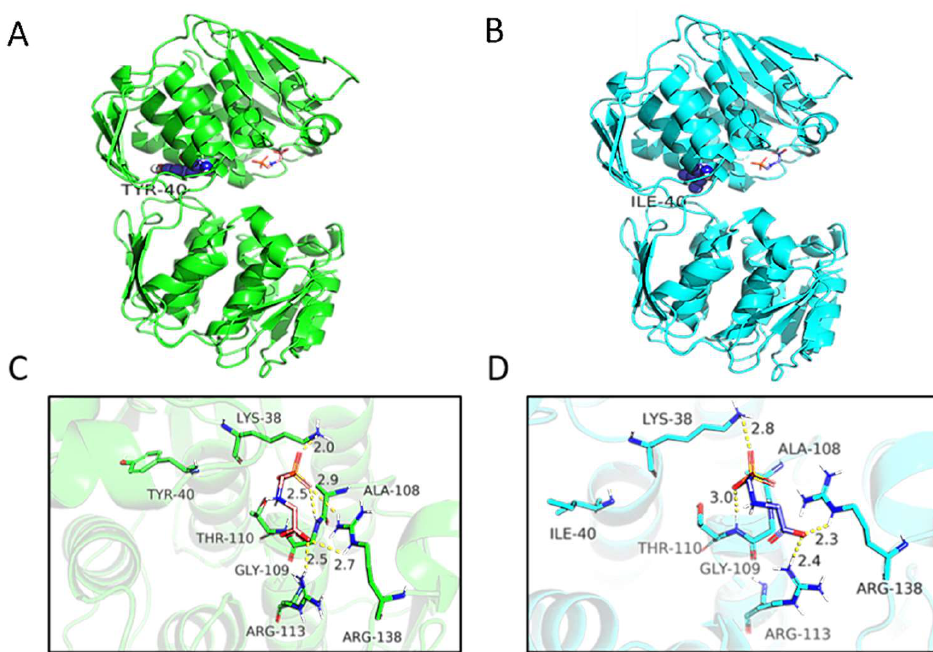
Figure 3. Ribbon diagram of the crystal structure of EPSPS and the active site in glyphosate-liganded EPSPS. ( A ) Crystal structure of the open conformation of GR79-EPSPS. Tyr-40 is shown in purple. ( B ) Crystal structure of the open conformation of GR79(Y40I)-EPSPS. Ile-40 is shown in purple. ( C ) The structure of the GR79-EPSPS·GLP complex. ( D ) The structure of the GR79(Y40I)-EPSPS·GLP complex. The yellow dotted line represents the hydrogen bond.